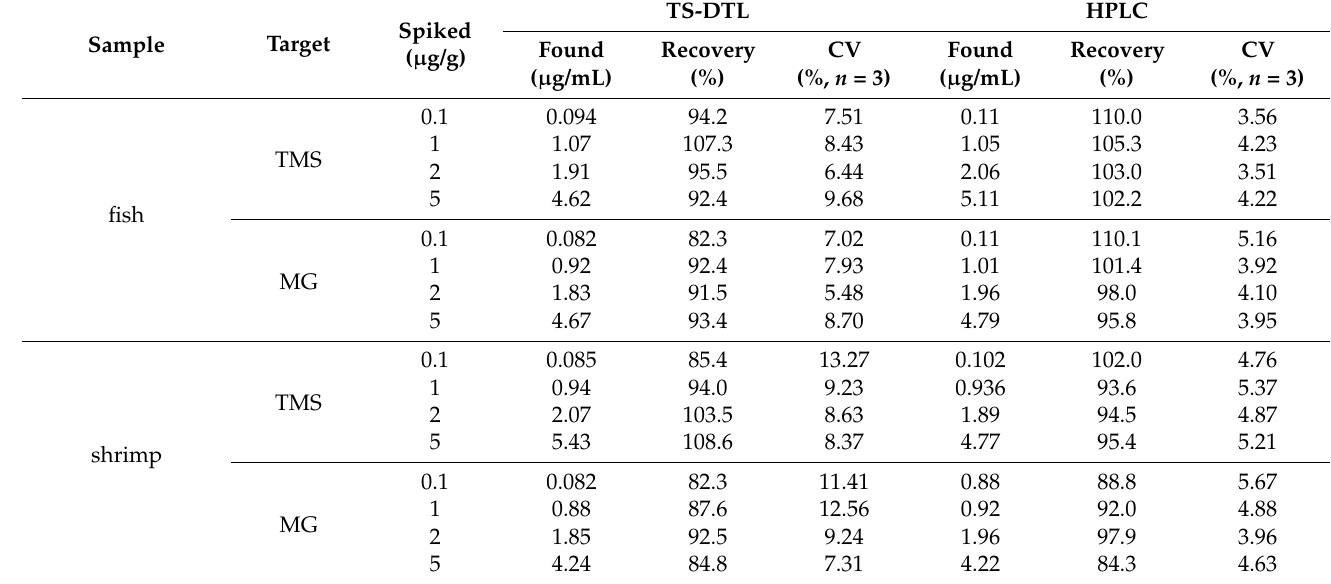
Table 3. Recovery evaluation in aquatic products by the developed TS-DTL and HPLC